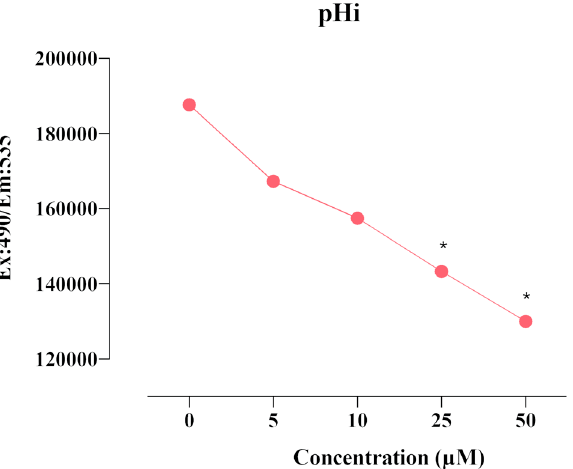
Figure 4. Measurement of pHi level in HeLa cells. A 25 µM dose of compound E inhibited CAIX and decreased intracellular pHi level in a dose-dependent manner. The data are presented as the mean ± SD (n = 3). * p < 0.05 compared with the control.